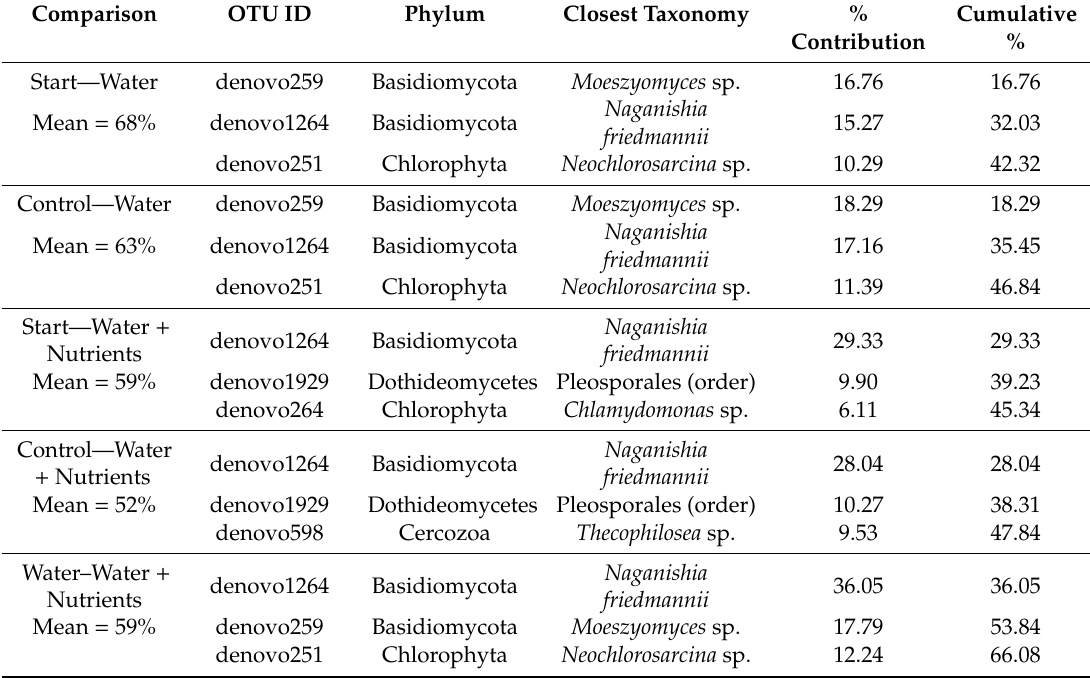
Table 2. Similarity percentage analysis (SIMPER) among microcosm treatments for 18S data. For each comparison, the unique OTU identifier, phylum, family, percent contribution to dissimilarity and cumulative percent contribution to dissimilarity are shown for the top three taxa contributing to the